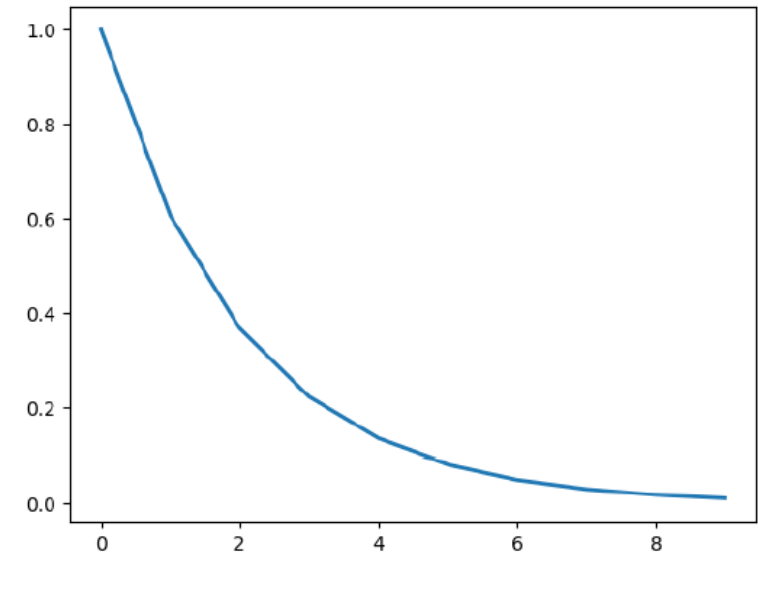
Figure 3. Attenuation function of e − γ d